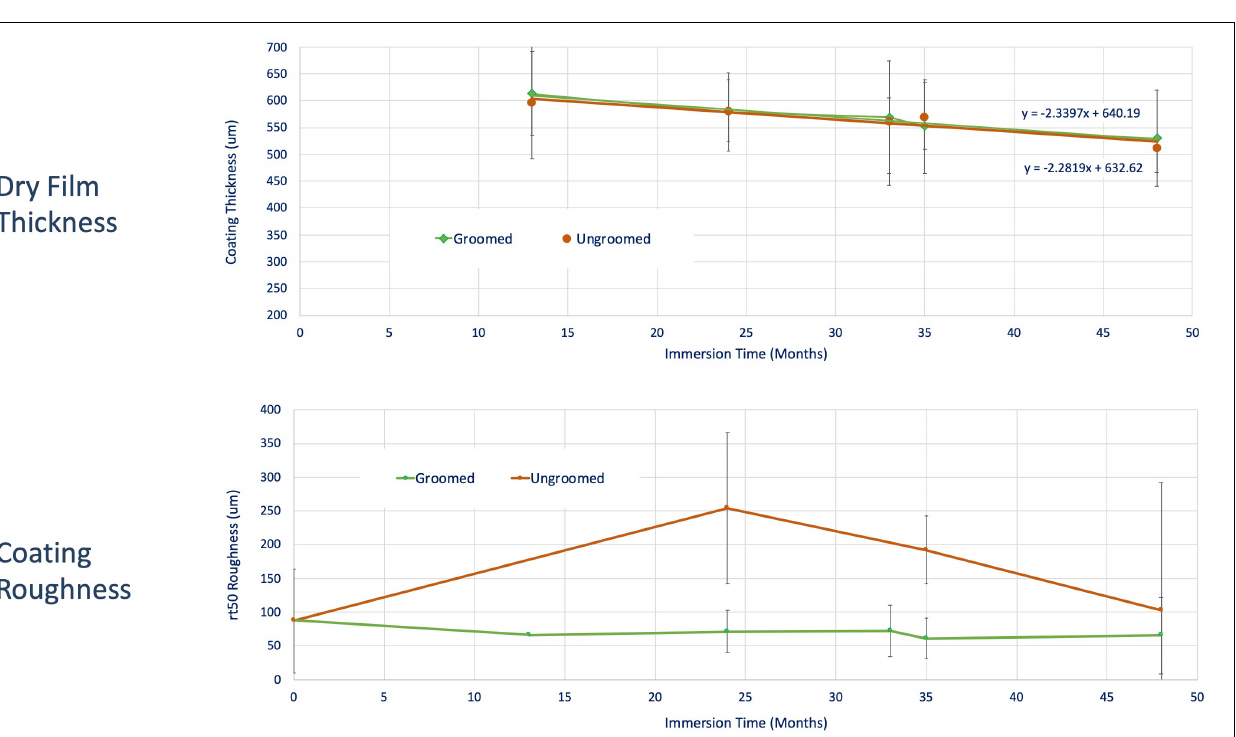
FIGURE 6 | Biofouling progression on ungroomed and groomed BRA 640 during a 54 months deployment.